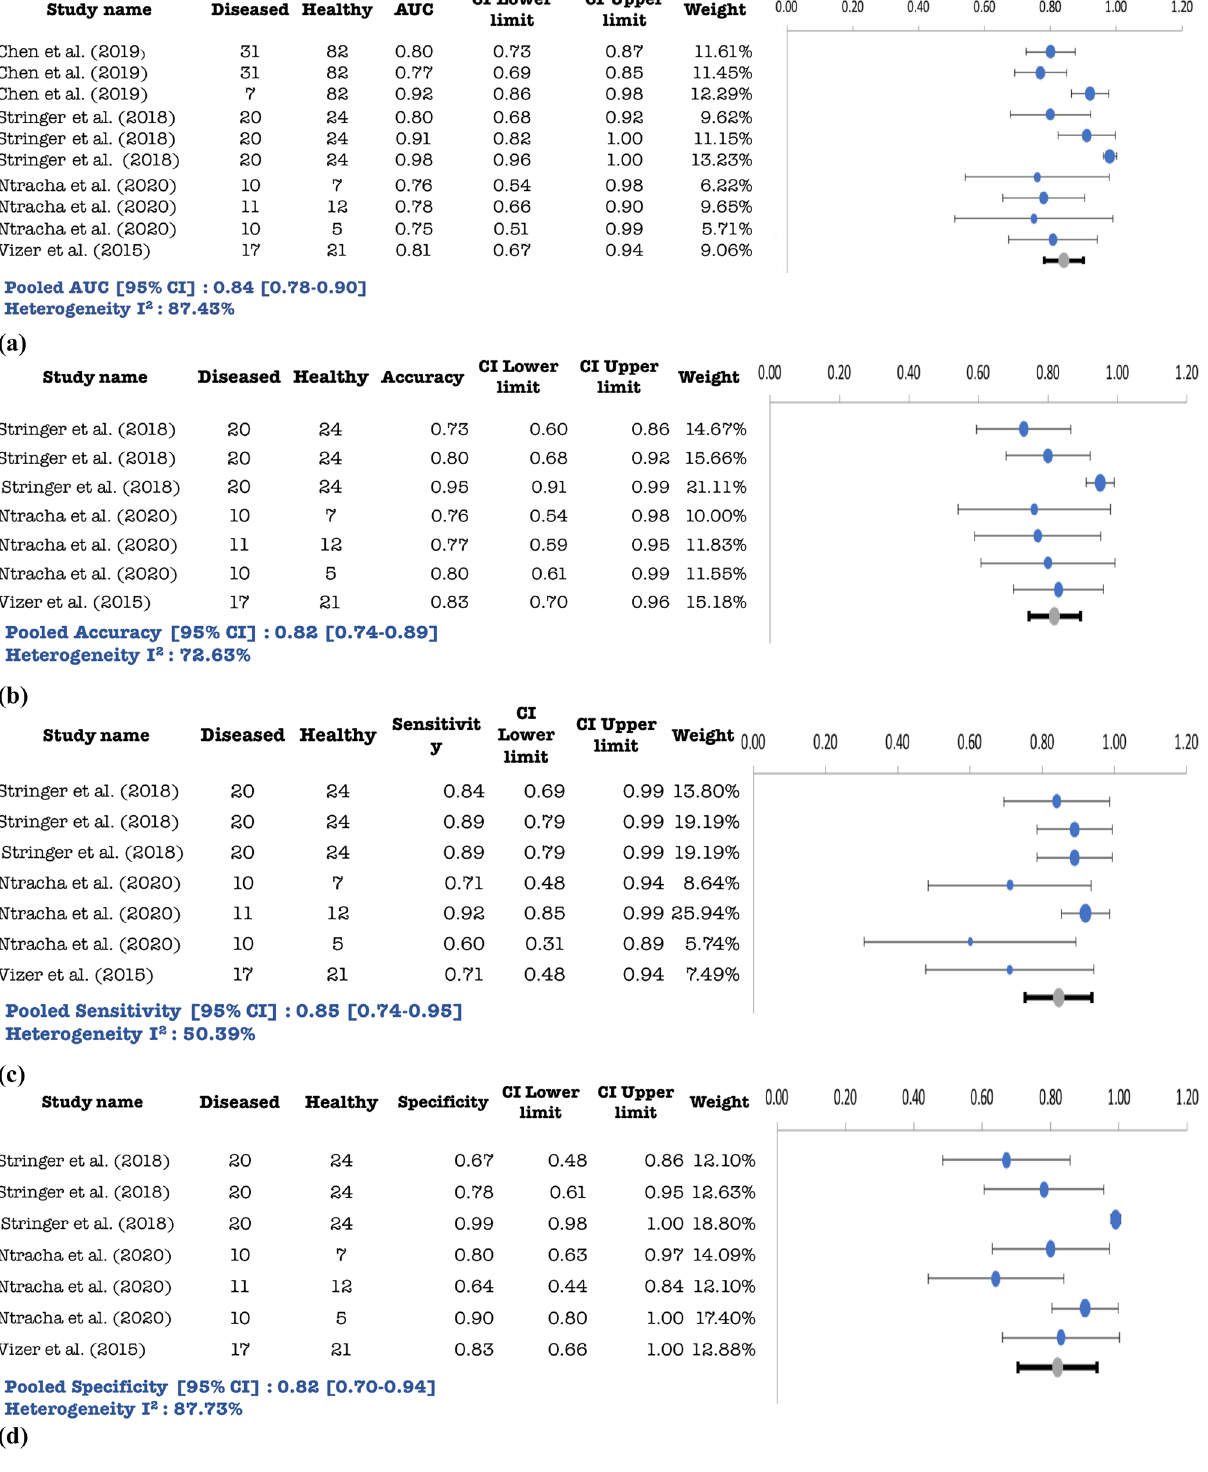
Figure 3. ( a ) Pooled AUC with 95% CI for MCI studies. ( b ) Pooled accuracy with 95% CI for MCI studies. ( c ) Pooled sensitivity with 95% CI for MCI studies. ( d ) Pooled specificity with 95% CI for MCI